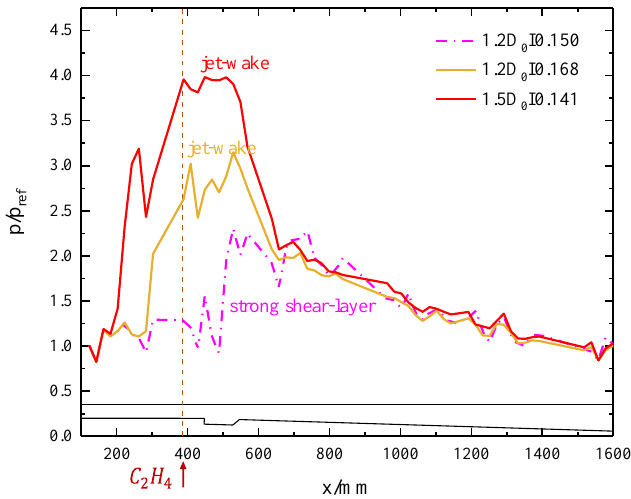
Figure 17. Dimensionless pressure along x axis to different injectors at more equivalence